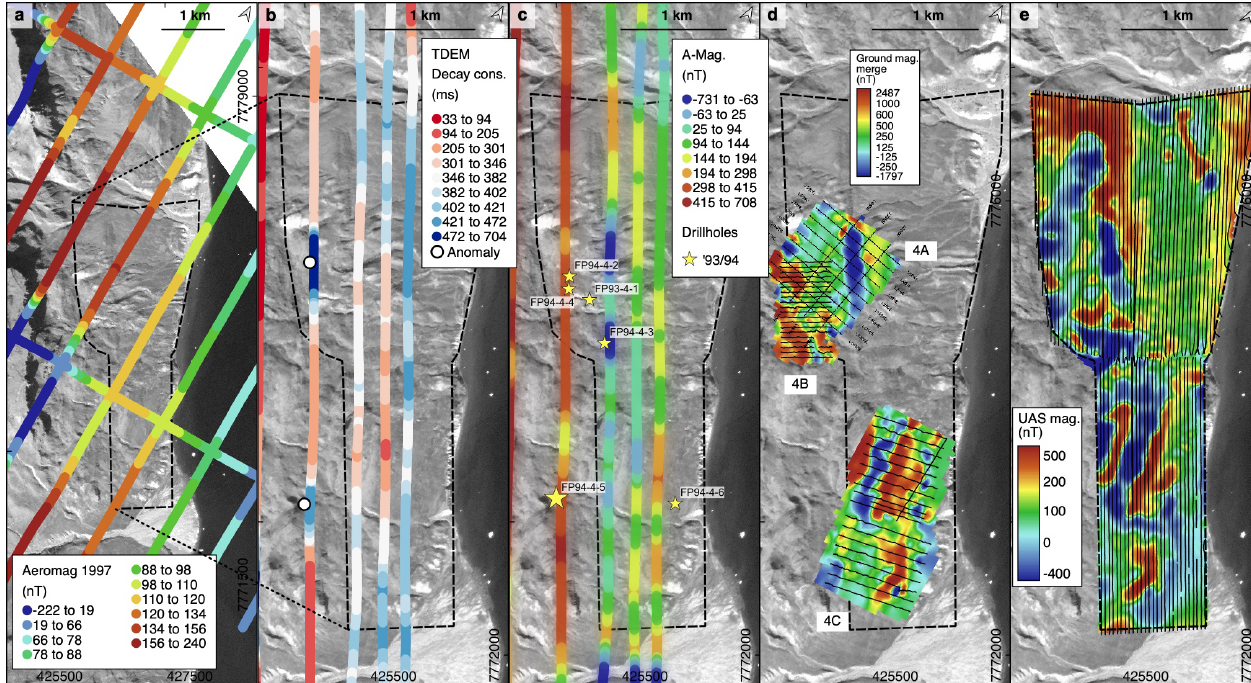
Figure 3. Overview of legacy airborne geophysical (time-domain electromagnetic (TDEM) and magnetic), ground-based magnetic and UAS- based magnetic data with the dashed line highlighting the UAS-based magnetic survey area of this study. The residual magnetic anomalies are shown (a) from the regional AEROMAG97 survey (Thorning and Stemp, 1998), (b, c) from the local exploration airborne survey (Olshefsky and Jerome, 1993) and (d) from ground-based surveys, conducted by Falconbridge Ltd. (grid 4A; Olshefsky and Jerome, 1994) and collected during our field campaign (grid 4B and 4C). The UAS-based magnetic anomaly map is shown in (e) for comparison. The decay constant determined from the electromagnetic data is shown in (b) . Two conductivity anomalies were identified (white dots) and considered as targets for further exploration (Olshefsky and Jerome, 1993). The flight trajectories are shown as black lines, and positions of legacy drillholes are indicated in (c) as stars.